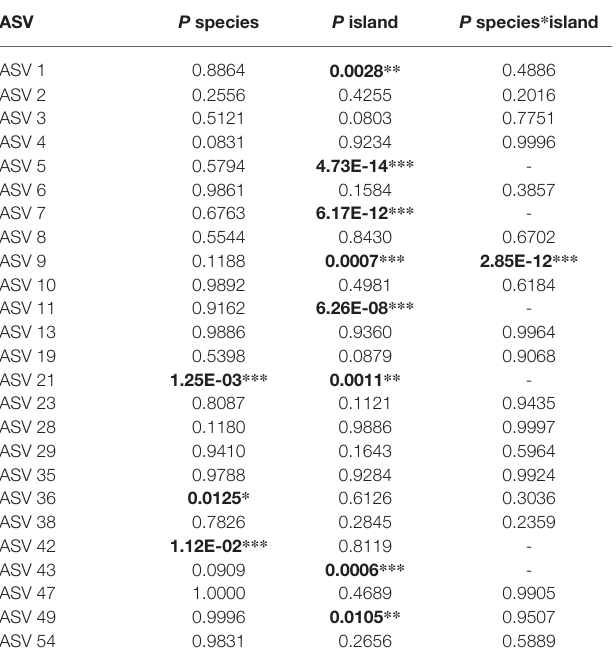
TABLE 1 | p- values of two-way ANOVA and Kruskal-Wallis test exploring the effect of island and/or mycobiont species on the frequency of each ASV. ASV P species